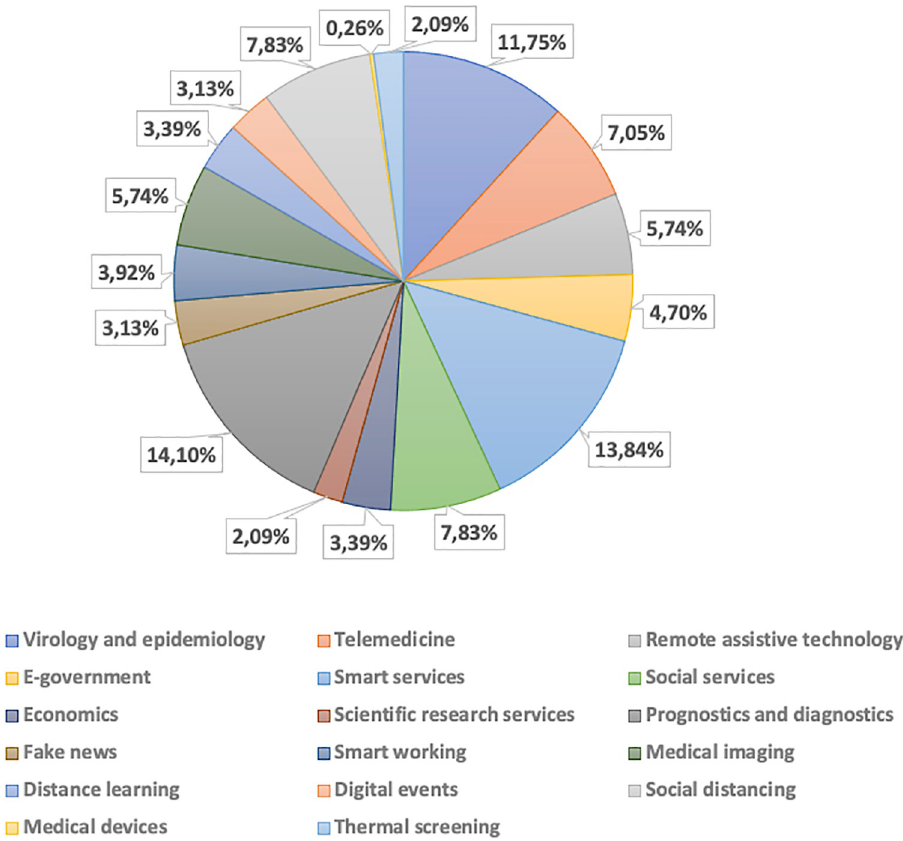
Fig 10. Statistics on the number of activities per application